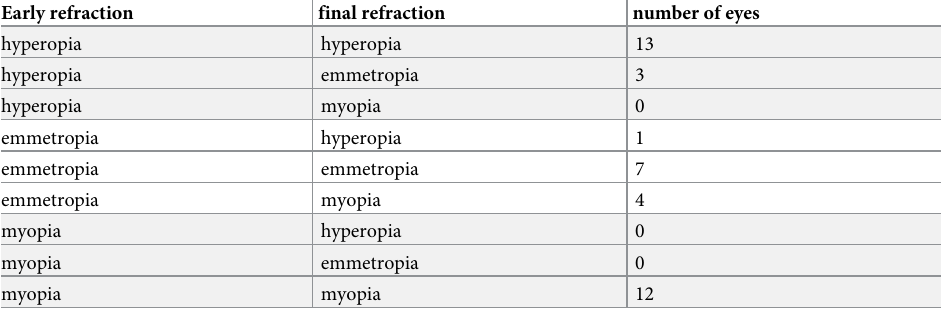
myopia myopia 12 early , refraction at latest follow up prior to and including 18 months of age. final , refraction at last follow up after 24 months of age. hyperopia , spherical equivalent � +1